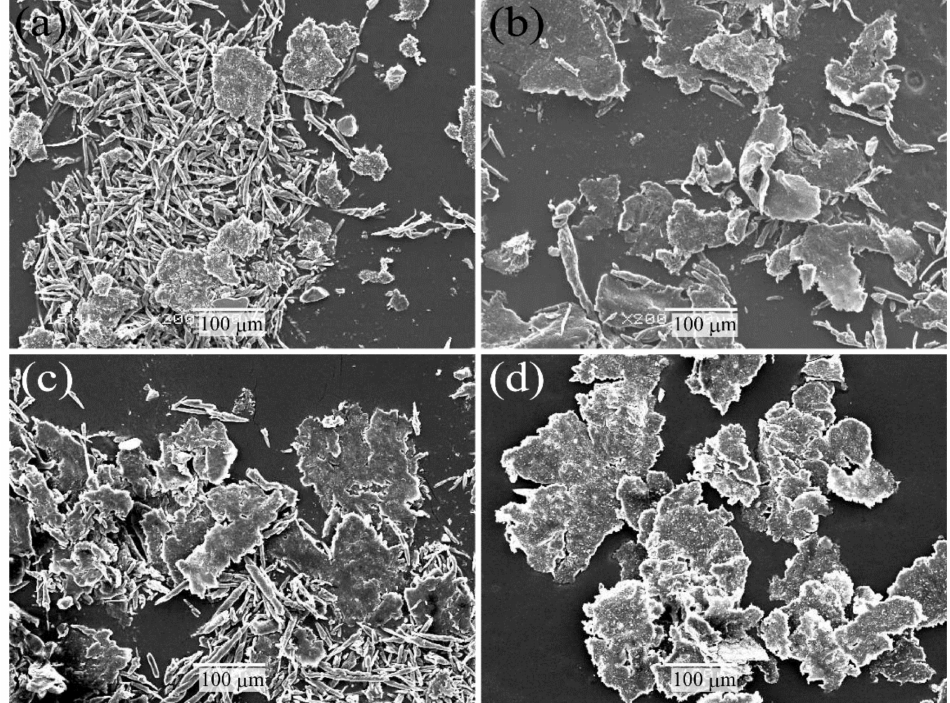
Figure 10. SEM photographs of wear debris after sliding wear tests of various surface-treated HF/PA1010 biomass composites: ( a ) HF_NaClO 2 , ( b ) HF_NaClO 2 + EP, ( c ) HF_NaClO 2 + A-1160, and ( d ) HF_NaClO 2 + A-1160 + EP ( ×